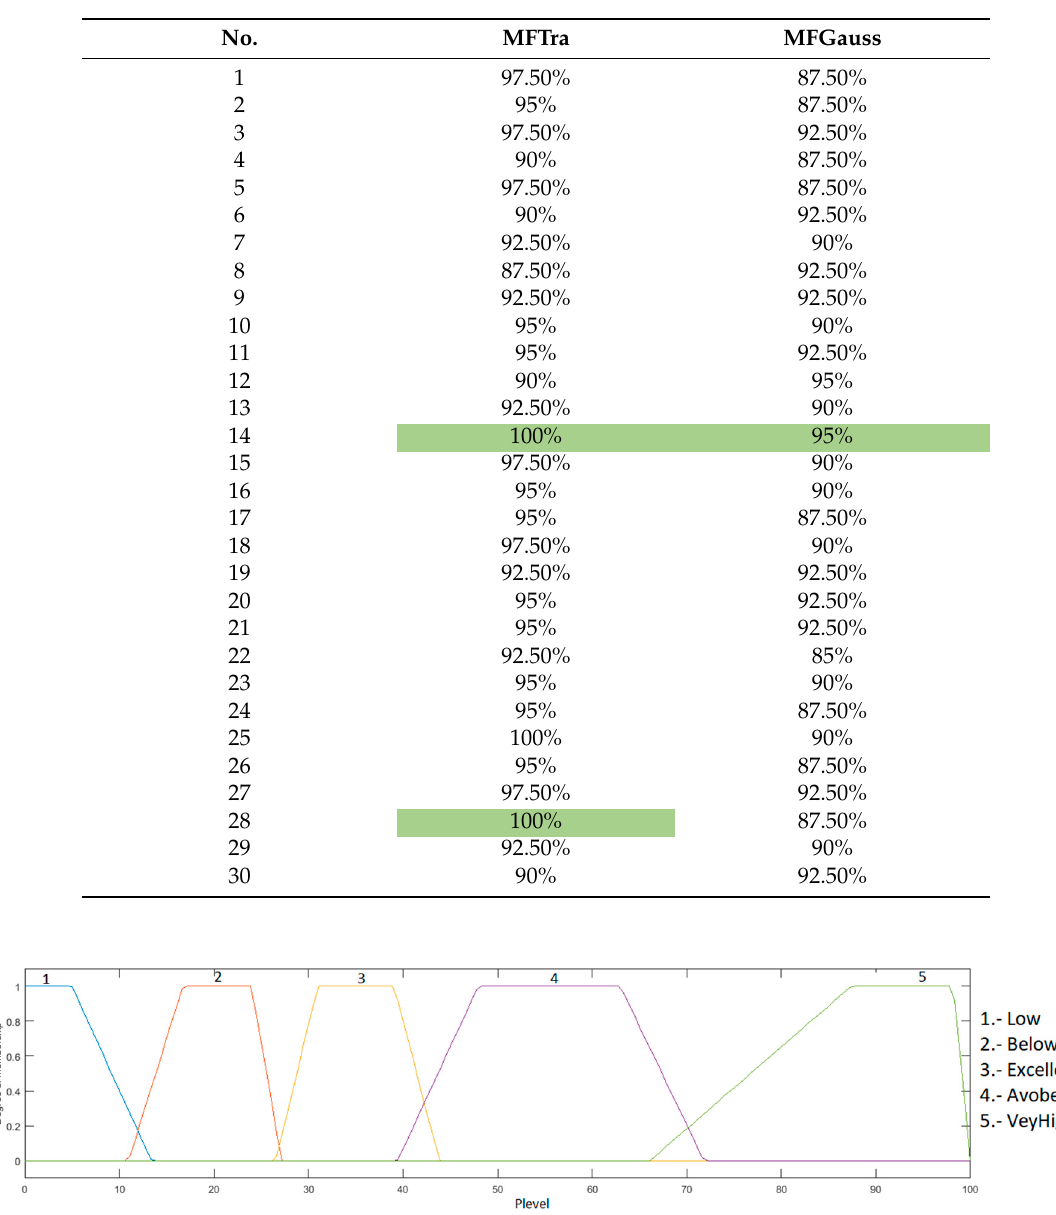
Figure 22. Optimized input age with Gaussian MFs. Figure 23. Optimized input heart rate with Gaussian MFs.